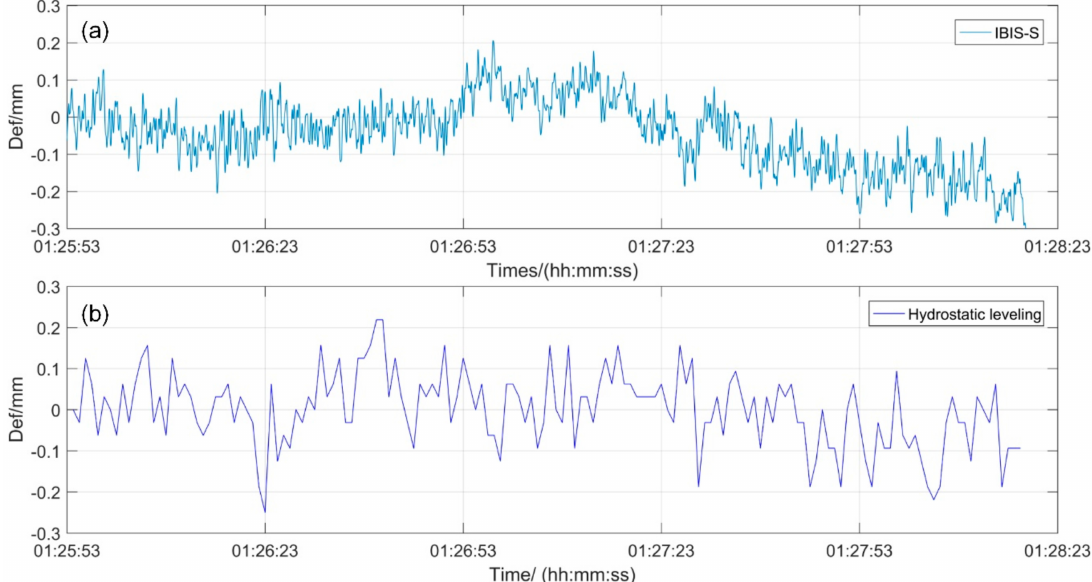
Figure 6. Displacements in mm due to ambient vibration in the middle of the 336 m-span achieved from ( a ) IBIS-S and ( b ) the hydrostatic